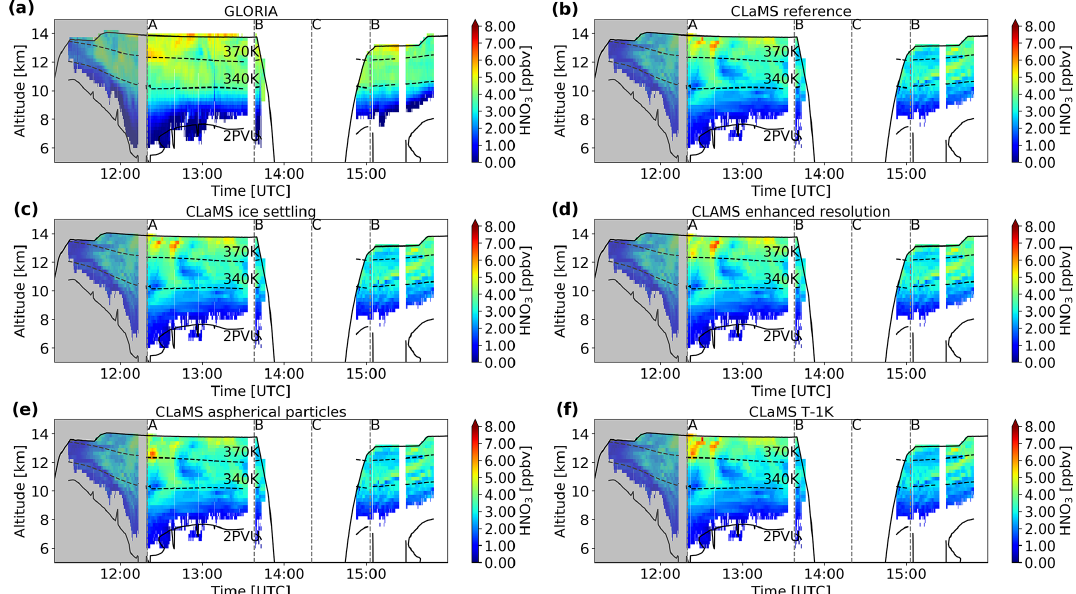
Figure B4. Cross sections of HNO 3 volume mixing ratio distribution for flight 21 on 18 March 2016 derived by GLORIA (a) and modelled by the CLaMS reference simulation (b) , and sensitivity simulations considering (c) ice formation on NAT particles, (d) temperature fluctuations, (e) growth rates of aspherical particles and (f) 1K global temperature offset. Flight altitude (bold black line), characteristic waypoints (A, B, C), 340 and 370K potential temperature levels (MERRA-2, dashed black lines), and 2PVU level (MERRA-2, black